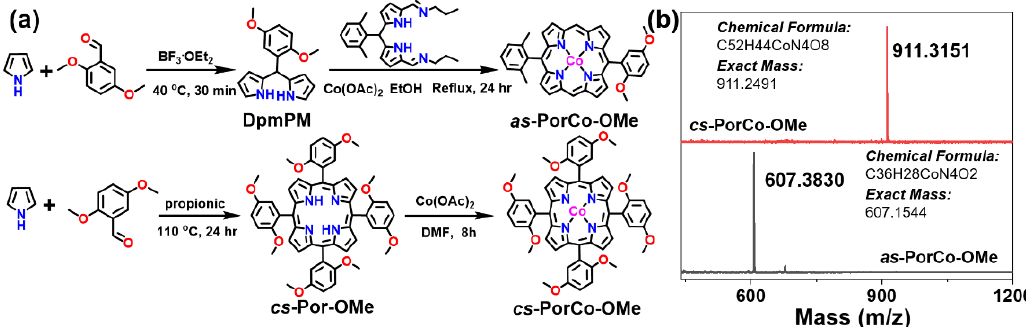
Figure 1. ( a ) synthetic route to the as -PorCo-OMe and cs -PorCo-OMe; ( b ) MALDI-TOF mass spectra of as -PorCo-OMe and cs -PorCo-OMe.